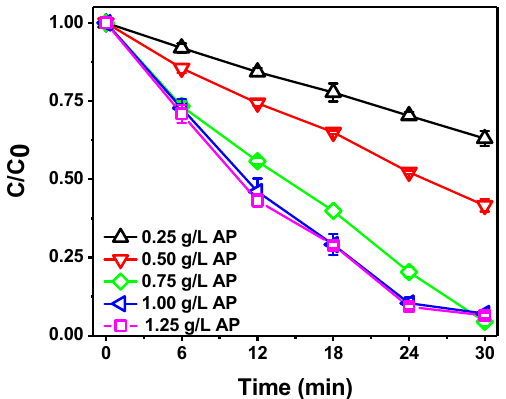
Figure 7. The effect of different concentration of Ag 3 PO 4 on the photocatalytic removal efficiency of bisphenol A with Ag 3 PO 4 as a photocatalyst under visible light irradiation.